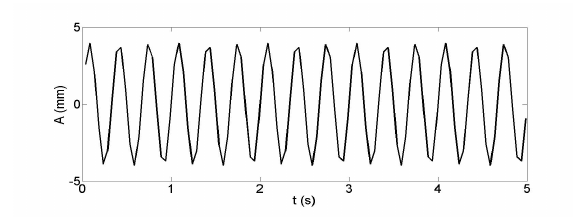
Figure 3b. Trajectory of the biased signal-20 Hz